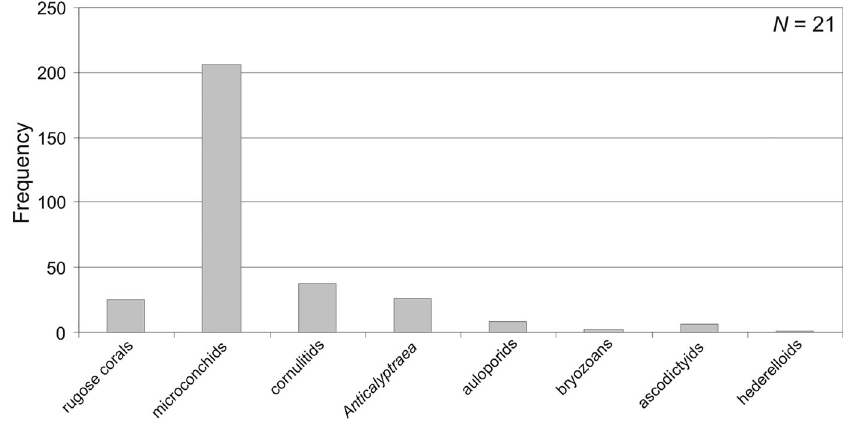
Fig. 6. Frequency of particular encrusters on the rugose corals from Kuressaare, Estonia. N = number of rugose